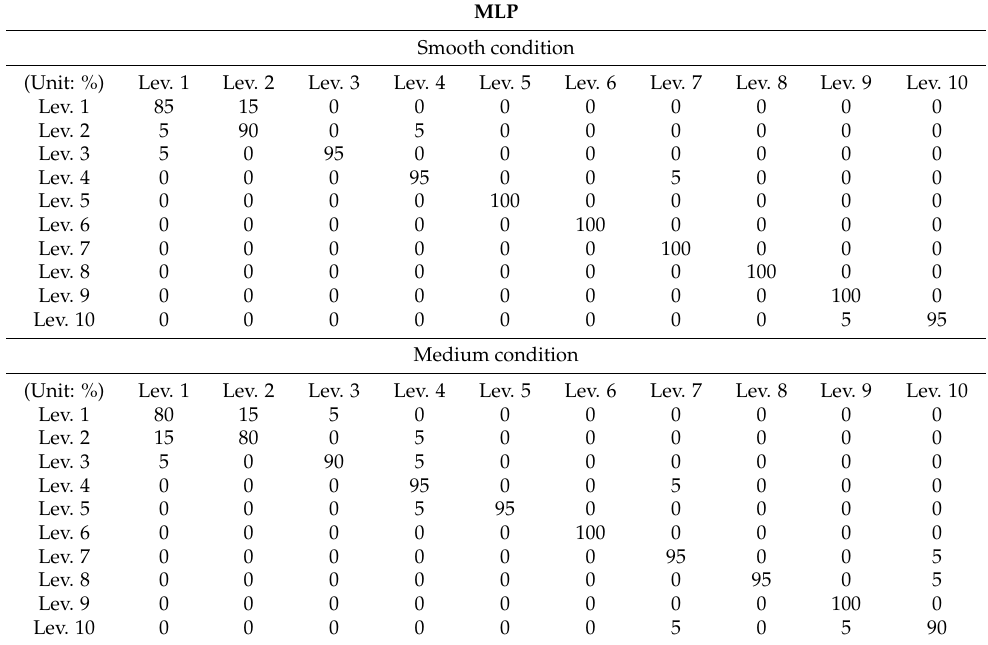
Table A3. Confusion matrices for the MLP model in three surface